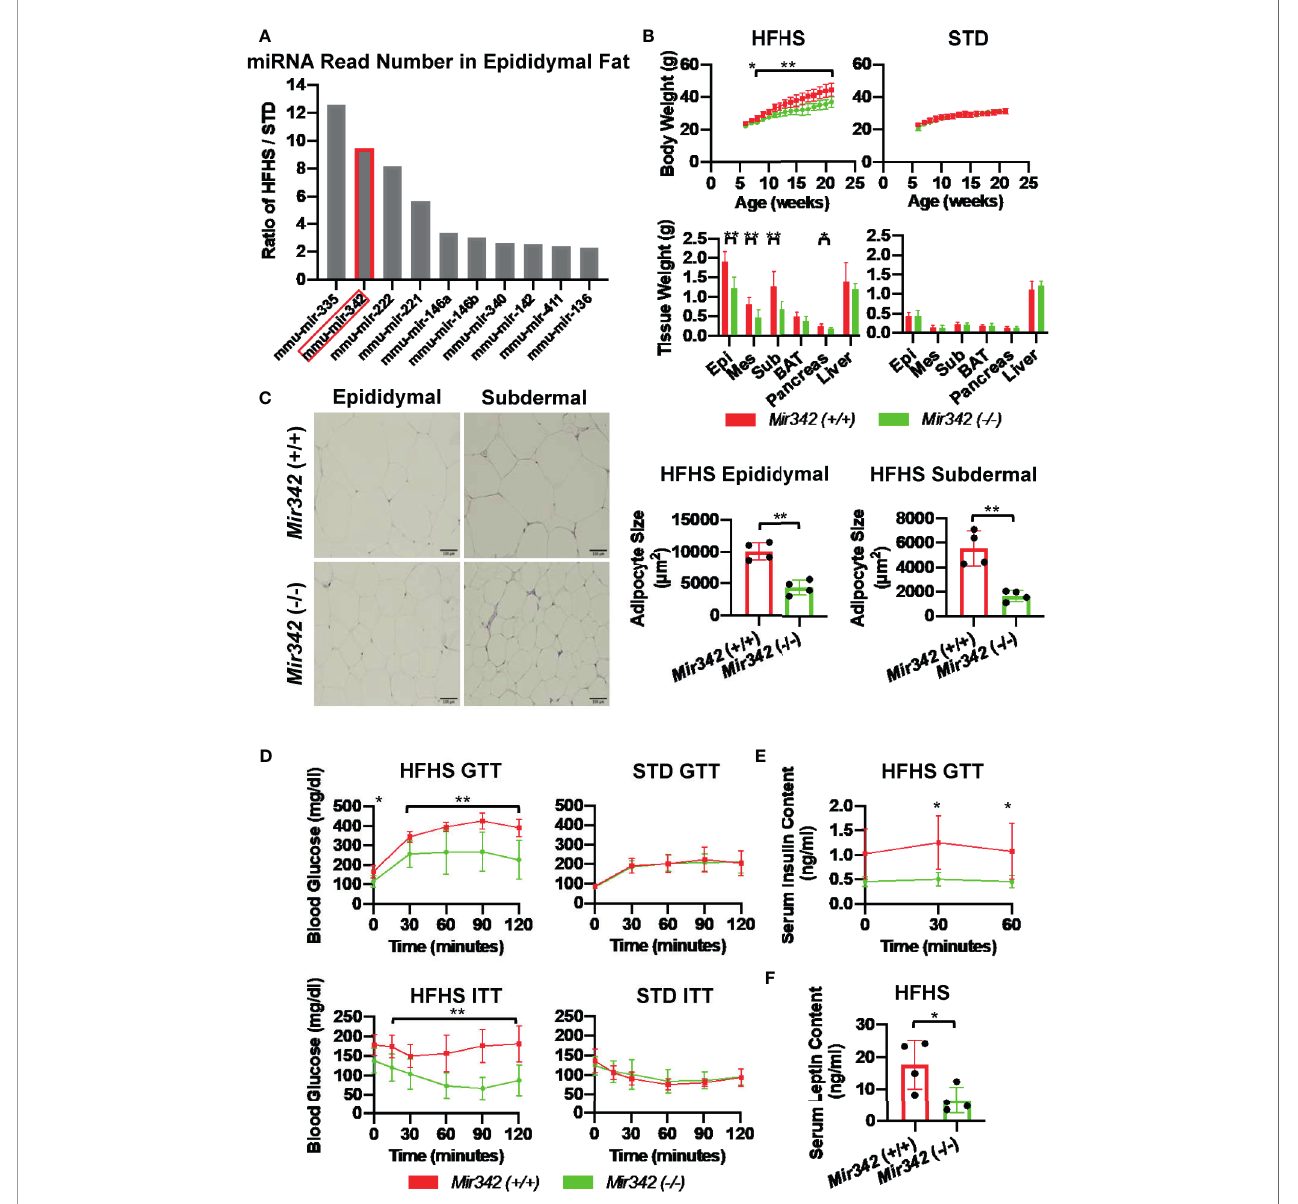
FIGURE 1 | The metabolic phenotypes of Mir342 (-/-) and Mir342 (+/+) mice fed with high fat-high sucrose (HFHS) or standard (STD) chow. (A) The HFHS/STD ratio of miRNA read numbers in epididymal fat tissues. (B) Body and tissue weight of Mir342 (+/+) and Mir342 (-/-) mice fed with HFHS (n=7) or STD chow (n=8). (C) Adipocyte area in epididymal and subdermal adipose tissues (n=4). Quantitative analyses were carried out on PAS-stained paraf fi n sections. (D) Glucose tolerance test (GTT) and insulin tolerance test (ITT) of mice fed with HFHS (n=7) or STD chow (n=8). (E) Serum insulin levels in Mir342 (+/+) and Mir342 (-/-) mice fed with HFHS chow during GTT (n=4). (F) Fasting serum leptin levels in Mir342 (+/+) and Mir342 (-/-) mice fed with HFHS mice (n=4). Data shown as mean ± SD and analyzed by independent t -test or two-way ANOVA with Bonferroni tests (*p < 0.05; **p <